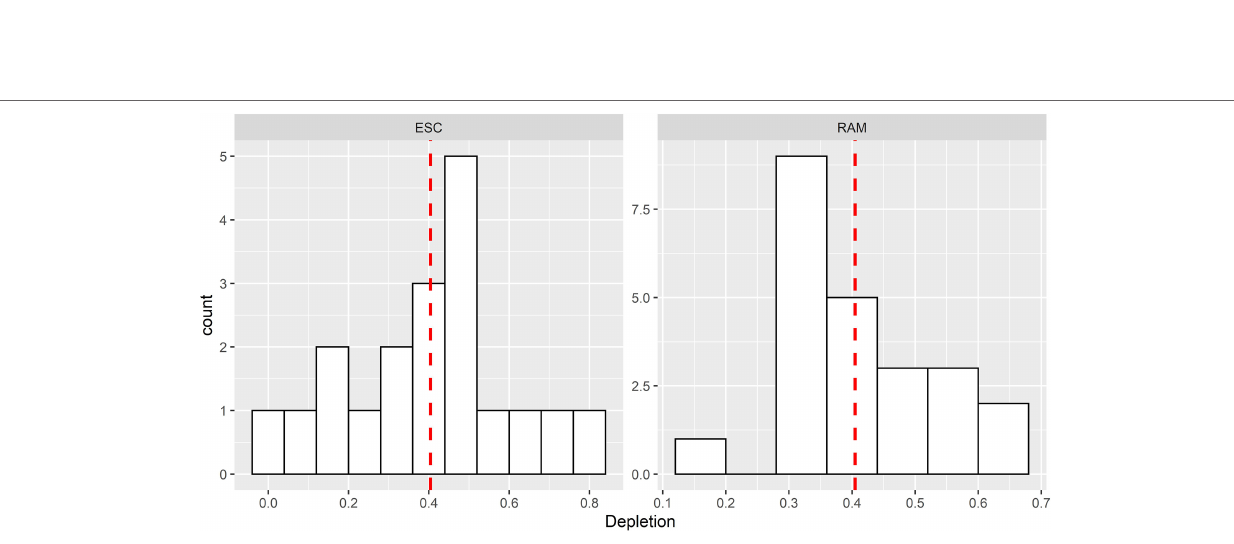
FIGURE 4 | Histograms of current depletion for 19 typical commercial fisheries in the ECS (left) and 23 selected data-rich stocks in RLSADB (right). The dashed line denotes the mean